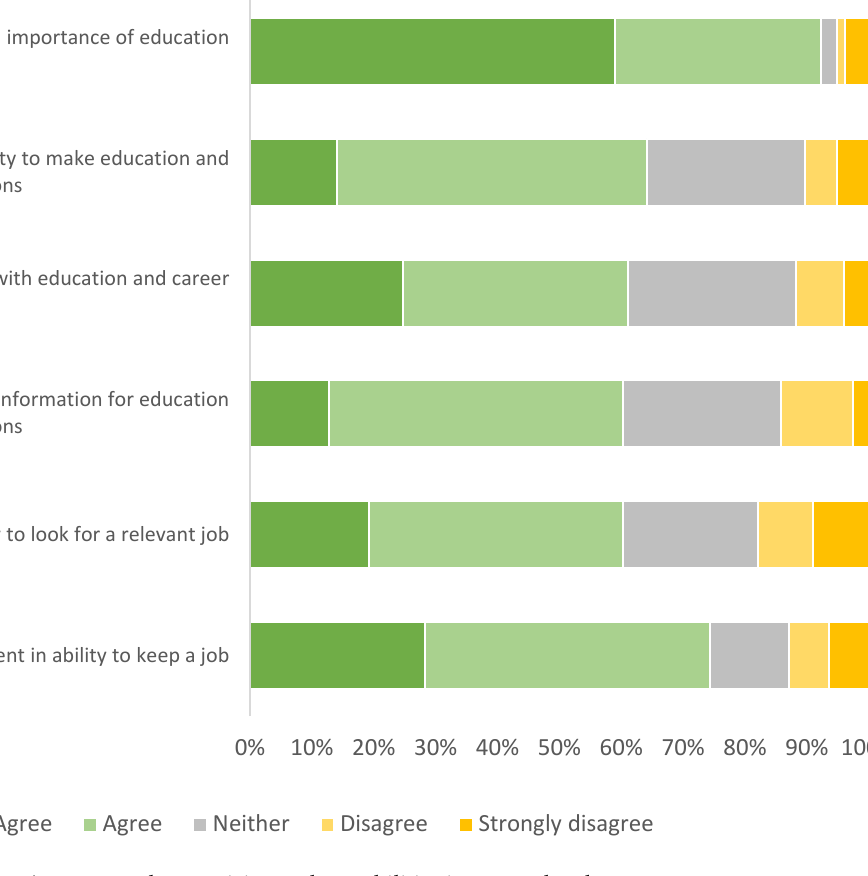
Figure 3. Agreement that participants have abilities in career development processes.